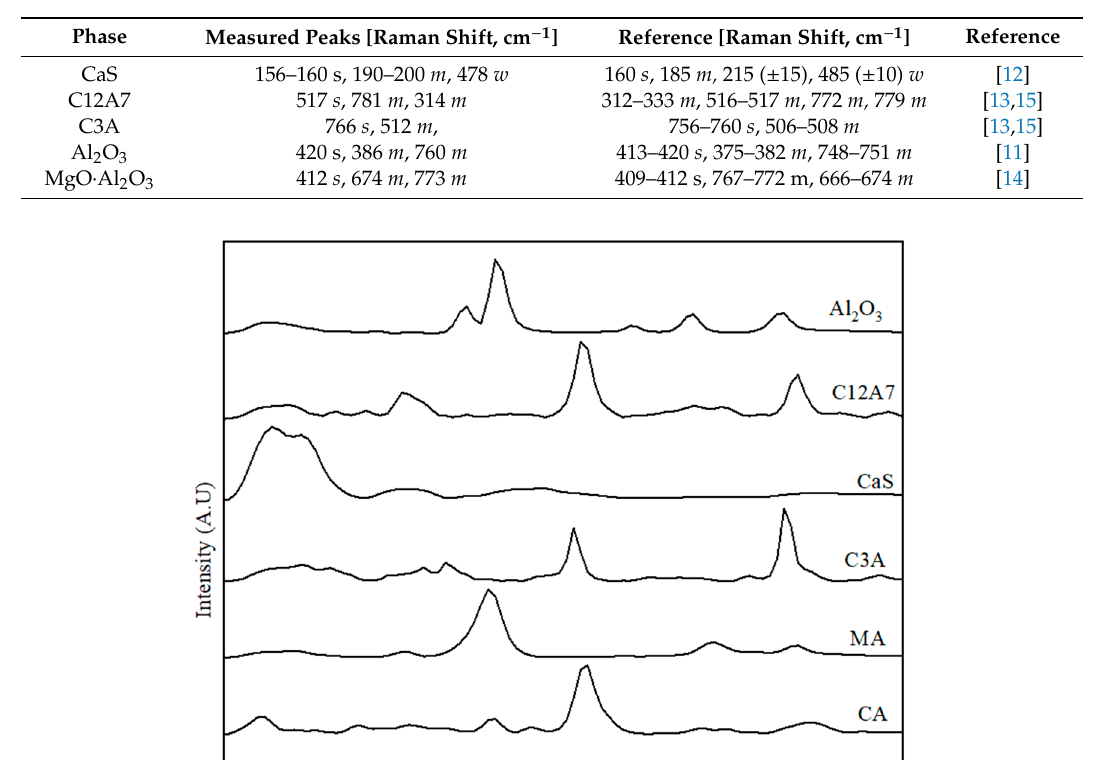
Table 2. Initial sample composition, XRD and XRF analyses for binary aluminum oxide-calcium sulphide phases of Al2O3–CaS.